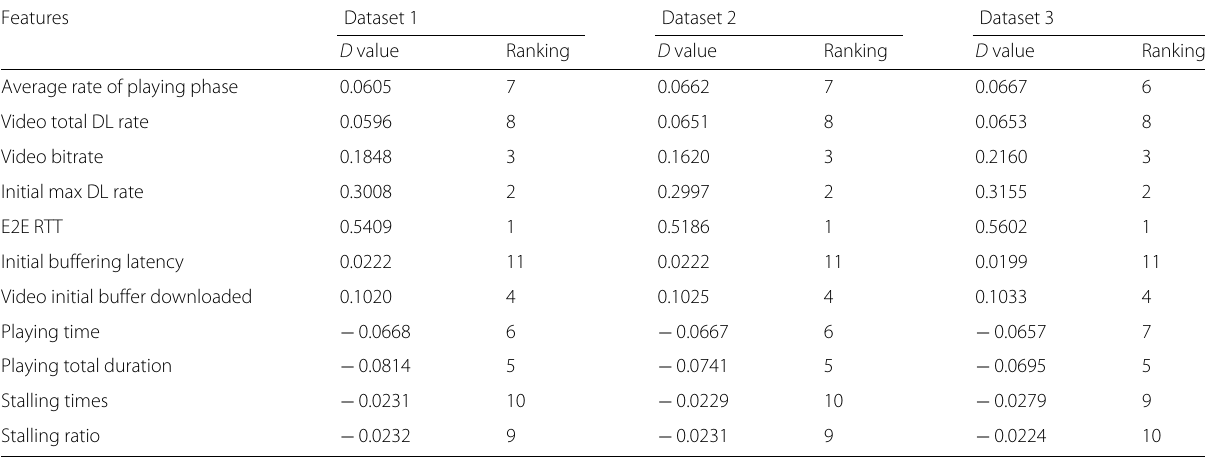
Table 8 D value and